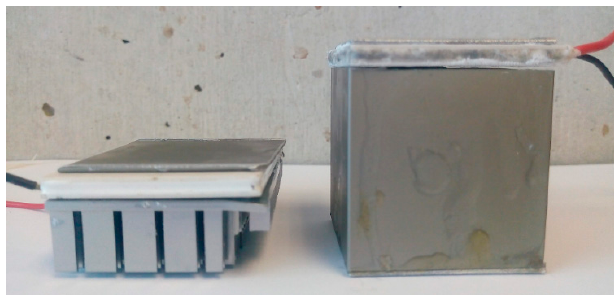
Figure 13. Comparison between heatsink and PCM cooling.